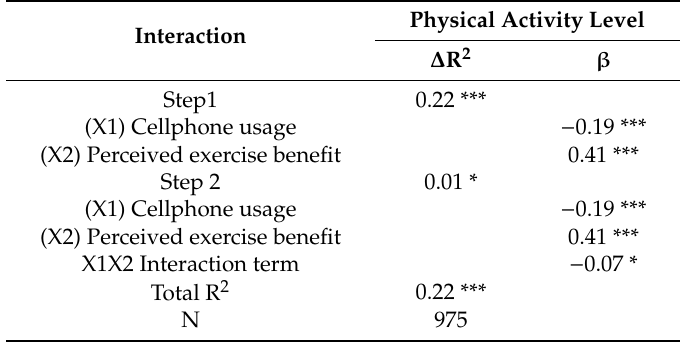
Table 2. Two-way interaction between cellphone usage and perceived exercise benefit.